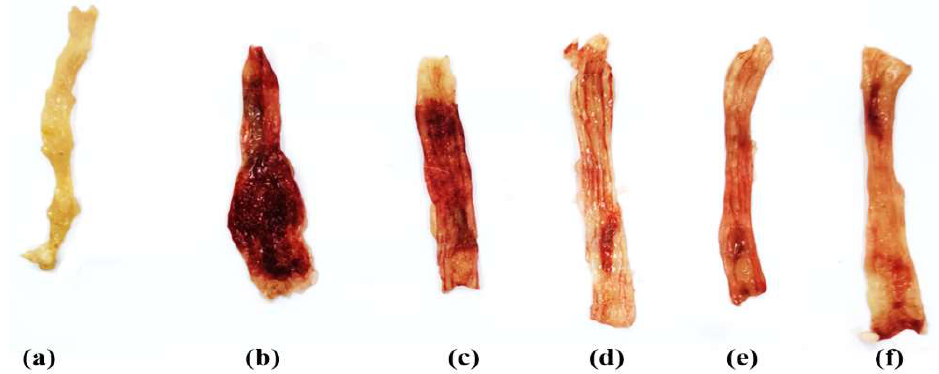
Figure 1. Effect of miconazole, sulfasalazine and their combination on the macroscopic appearance of the colonic mucosa: ( a ) NC, negative control group; ( b ) UC, positive control group; ( c ) MIC-20, miconazole 20 mg/kg/day-treated group; ( d ) MIC-40, miconazole 40 mg/kg/day-treated group; ( e ) SSZ-100, sulfasalazine 100 mg/kg/day-treated group; ( f ) MIC + SSZ, combination therapy-treated group.